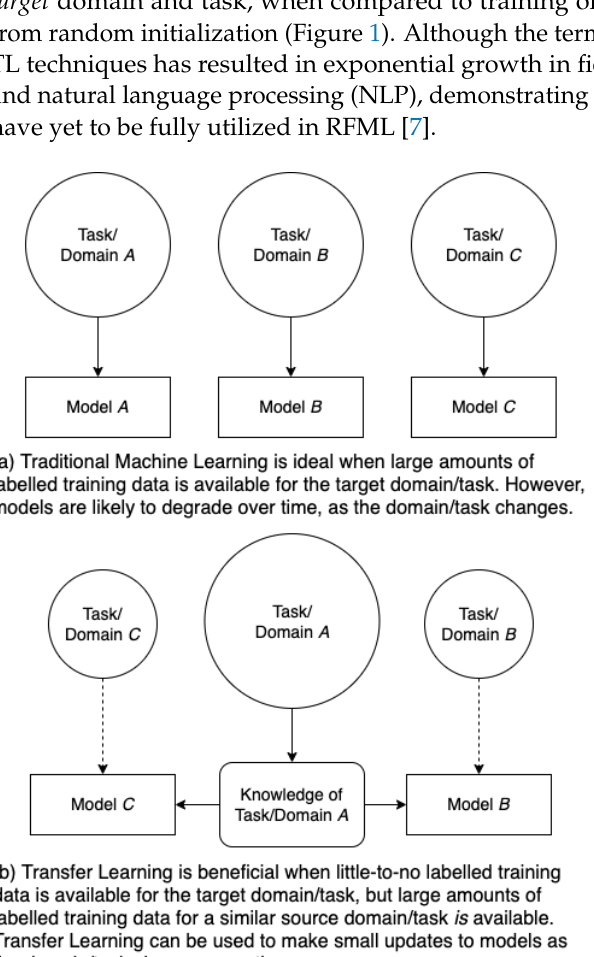
Figure 1. The difference between traditional ML ( a ), in which a new model is trained on a each domain/task pairing from random initialization, and TL ( b ), in which prior knowledge learned on one domain/task is used to support performance on a second domain and/or task where less (or no) labelled data were